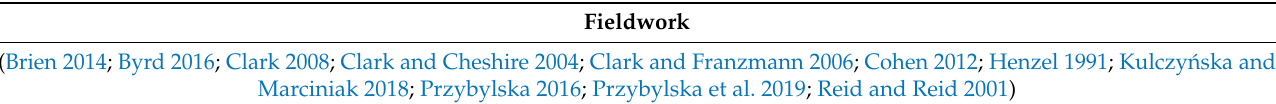
Table 1. Research on roadside memorials by